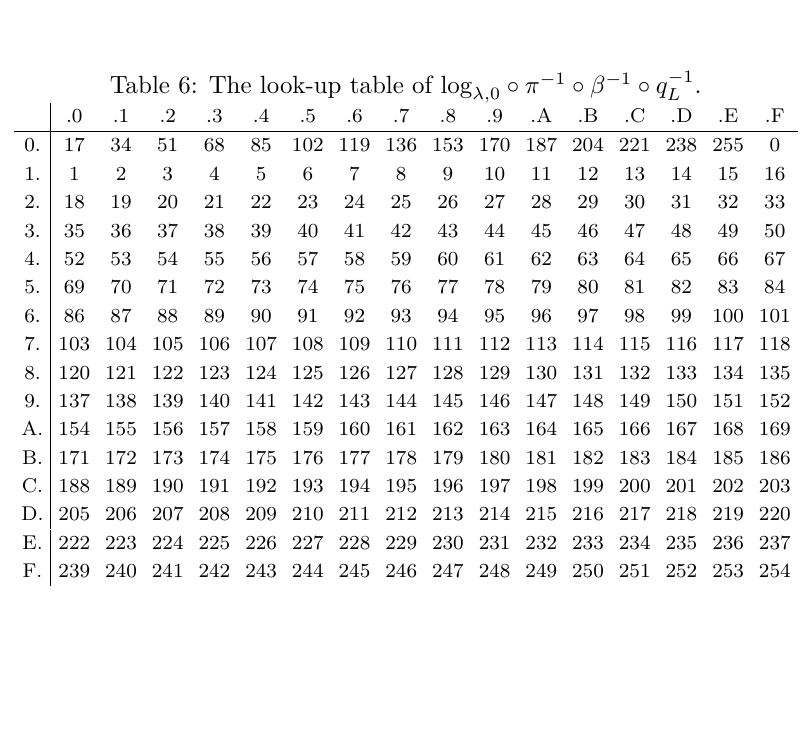
∘ 𝜋 − 1 ∘ 𝛽 − 1 ∘ 𝑞 − 1 𝜆, 0